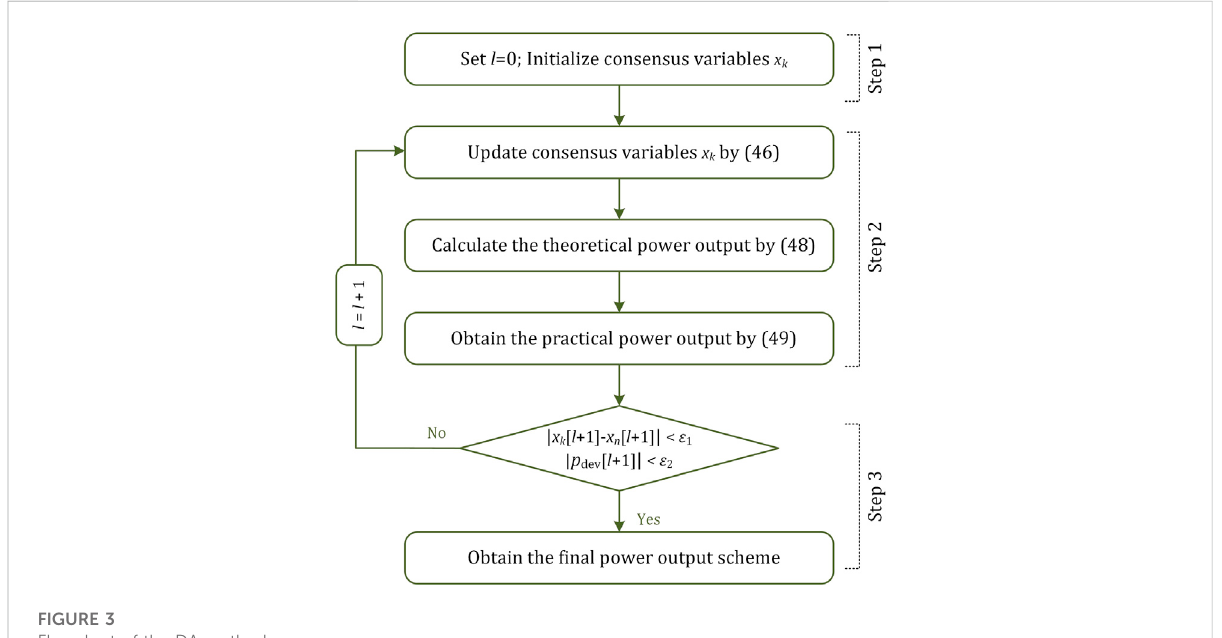
FIGURE 3 Flowchart of the DA